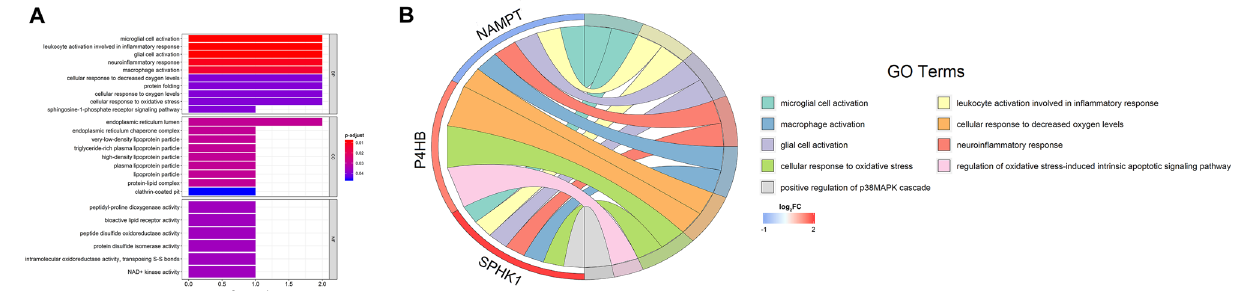
Figure 8. GO enrichment analysis of PDEARGs. ( A ) Bar plot of enriched GO terms. ( B ) Chord plot of enriched GO terms. FDR < 0.05 was considered statistically significant.